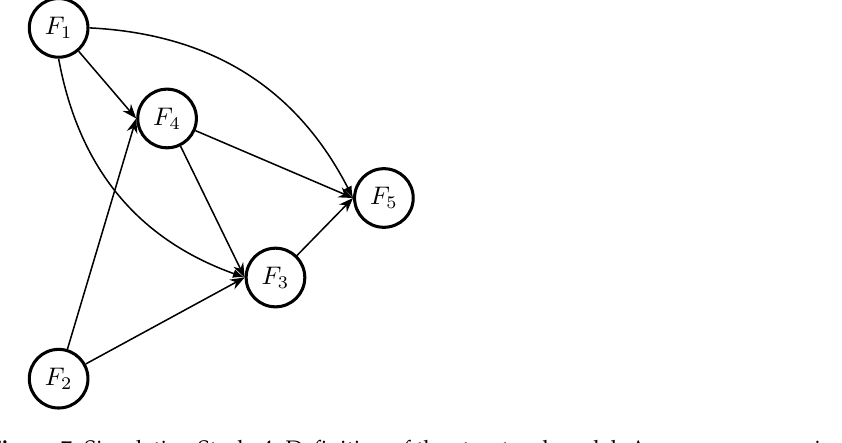
Figure 7. Simulation Study 4: Definition of the structural model. A common regression coefficient β is assumed for all